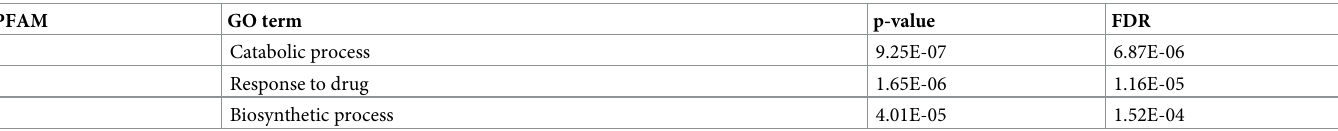
taxonomical groups. The abundance of TFs for each genome is shown on the y axis. Each